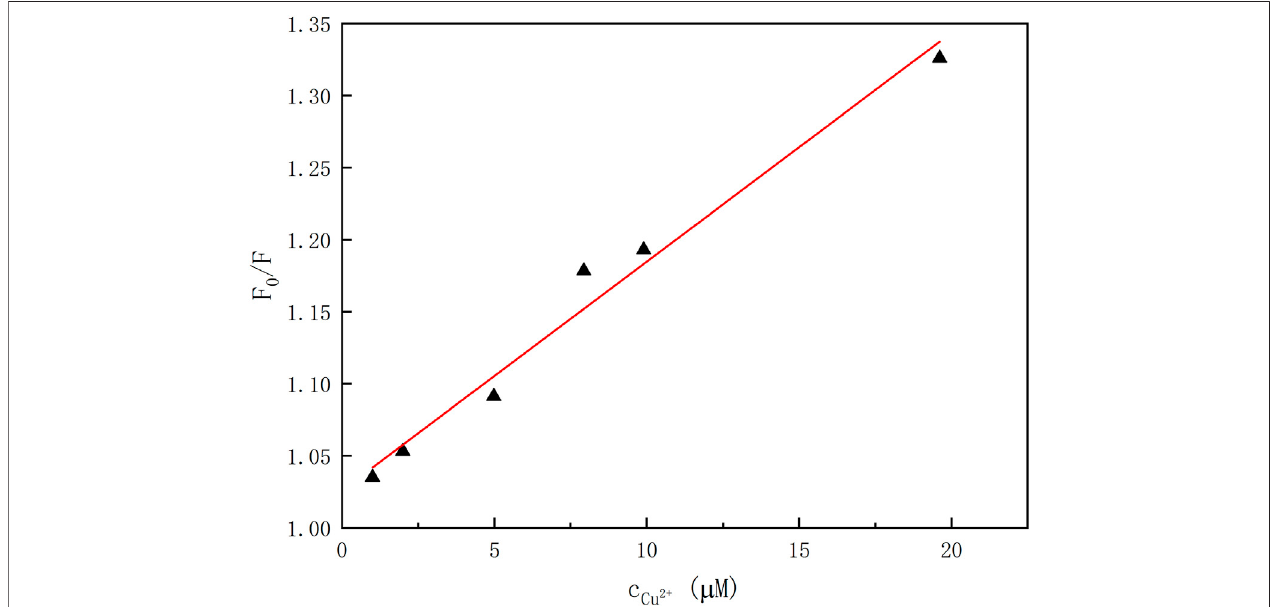
FIGURE 5 | Plot of emission intensity versus the concentrations of Cu 2+ ion ( λ em (cid:1) 405 nm, λ ex (cid:1) 334 nm).